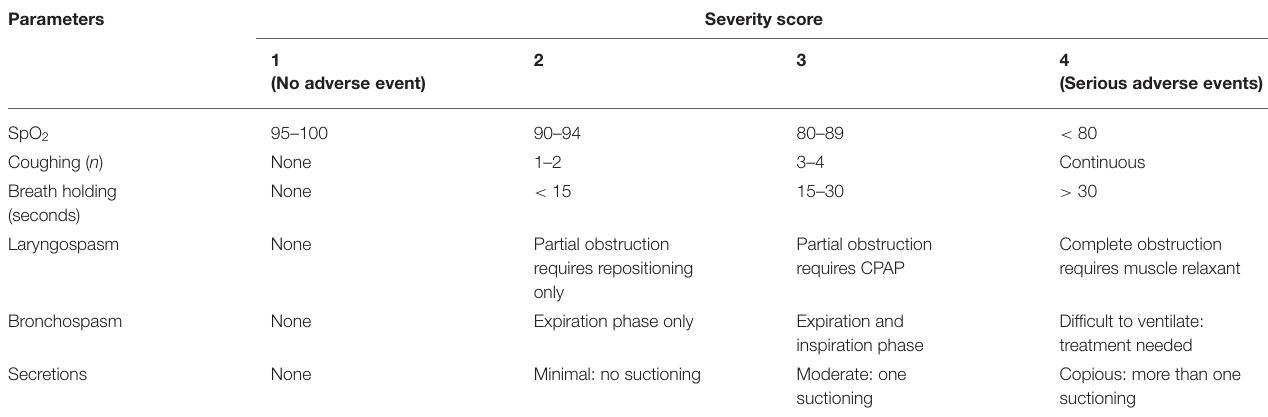
TABLE 1 | Perioperative respiratory adverse events severity scoring in pediatrics patients underwent surgery under general anesthesia.